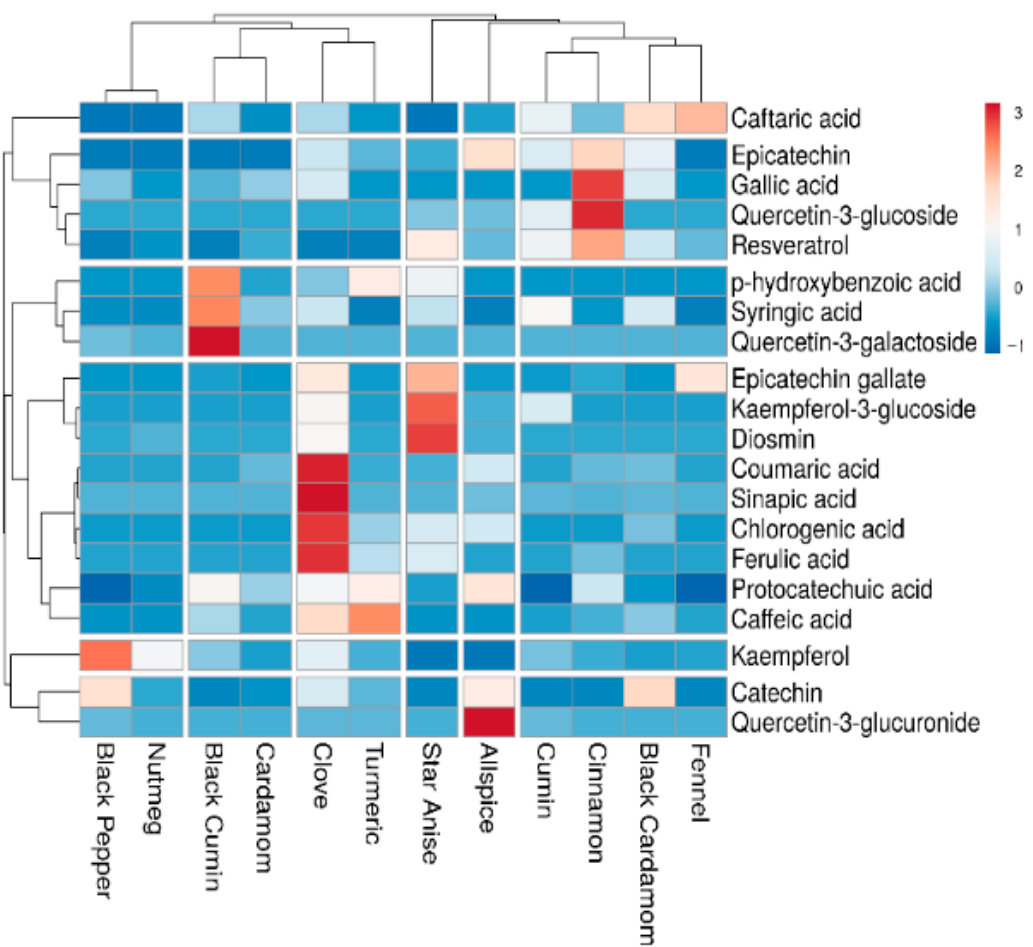
Figure 1. Heatmap showing “distribution and concentration” of quantified phenolic compounds (mg/g) in all spices. Red color boxes indicating the higher concentration while blue color boxes showing lower or zero concentration.